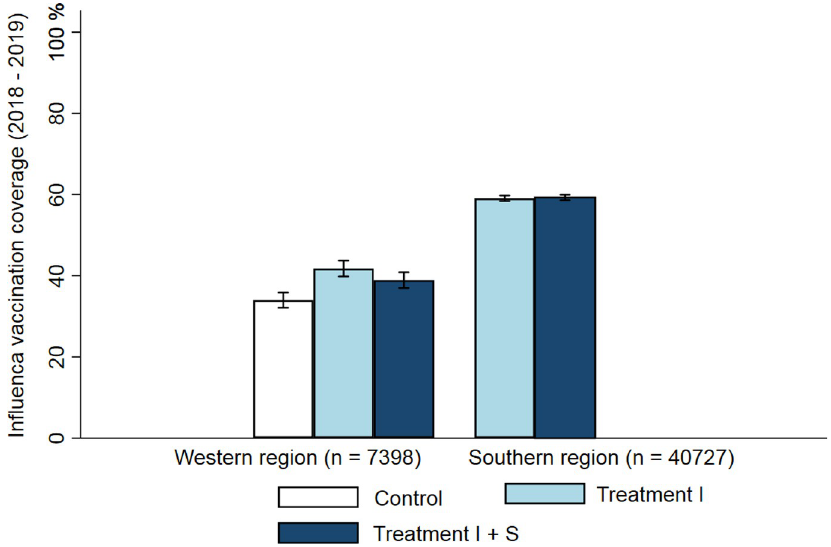
Fig 2. Vaccination coverage by region and treatment. Control = No reminder, Treatment I = individual-benefit reminder, and Treatment I + S = individual- and social-benefit reminder. Bar graphs denote influenza vaccination coverage. Error bars denote 95% confidence